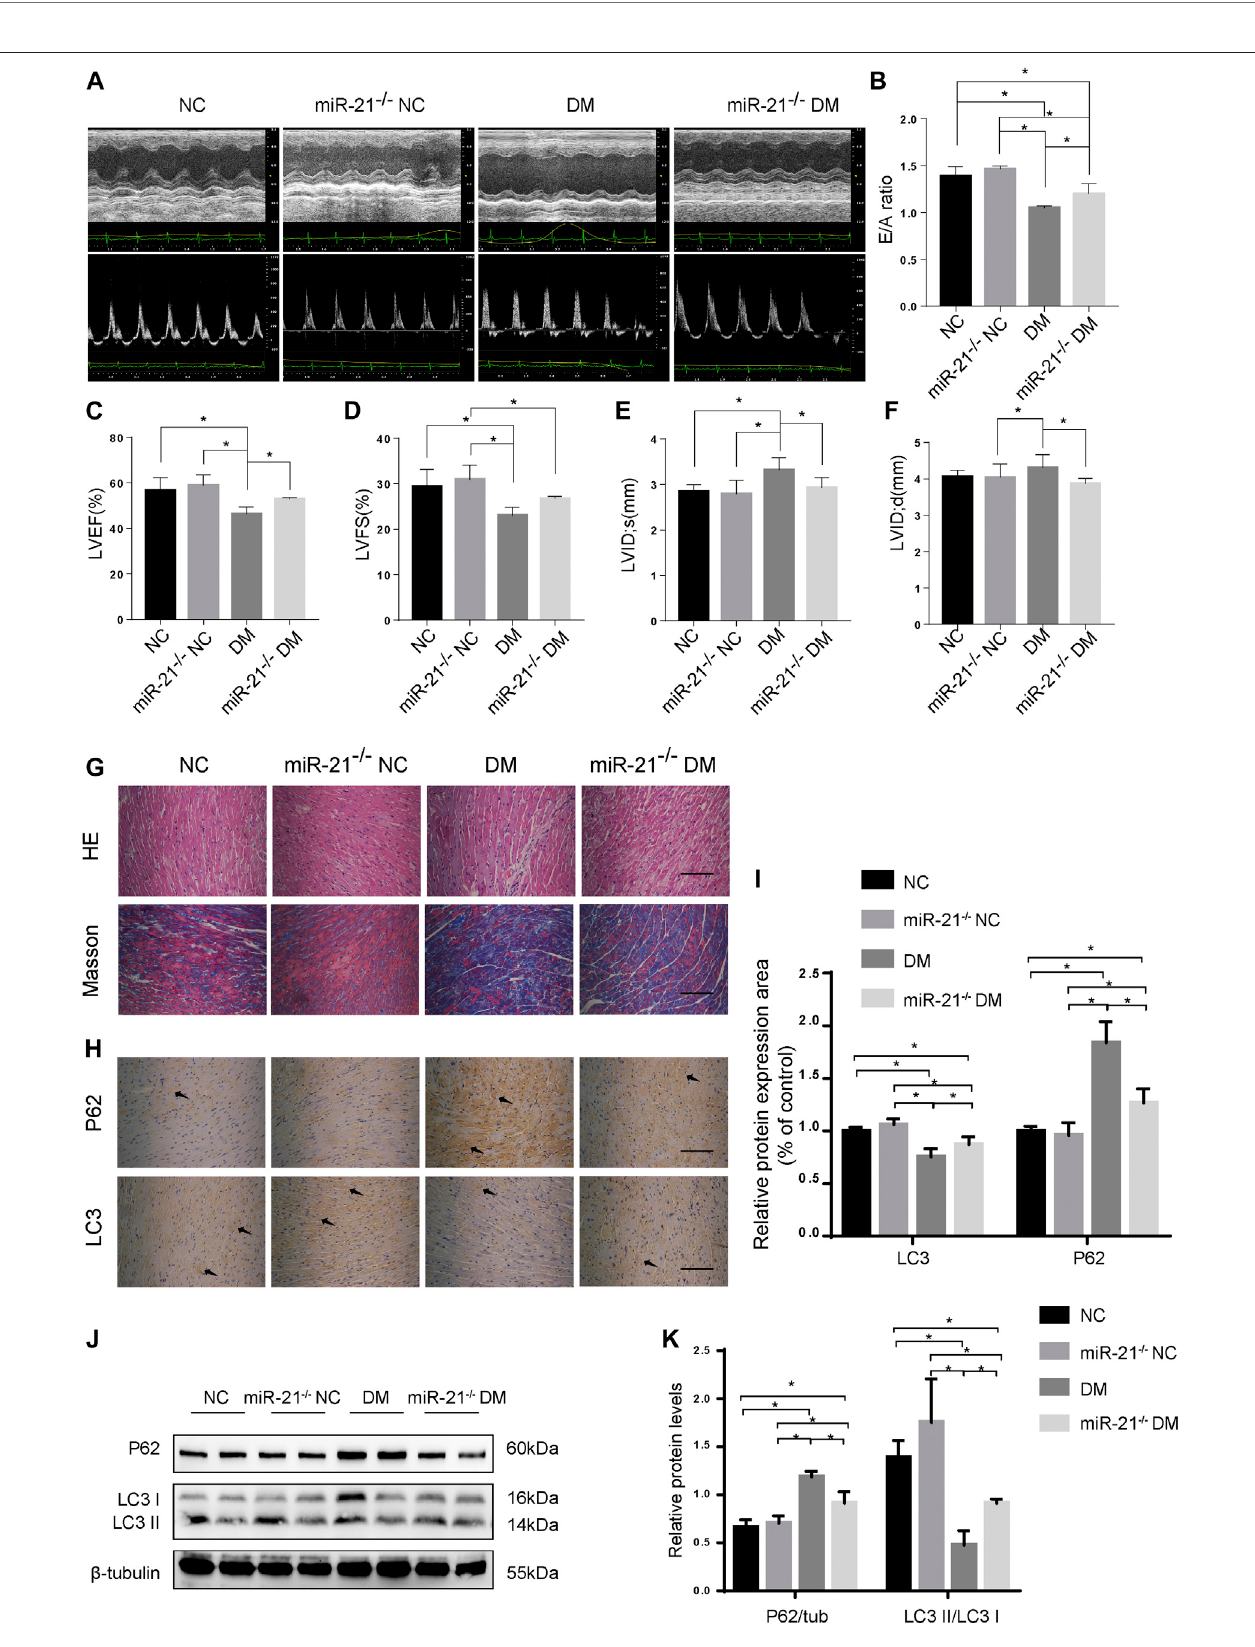
FIGURE 4 | miR-21 regulates autophagy in DM mice. (A) M-mode echocardiograms and pulse-wave Doppler echocardiograms was used to examine cardiac